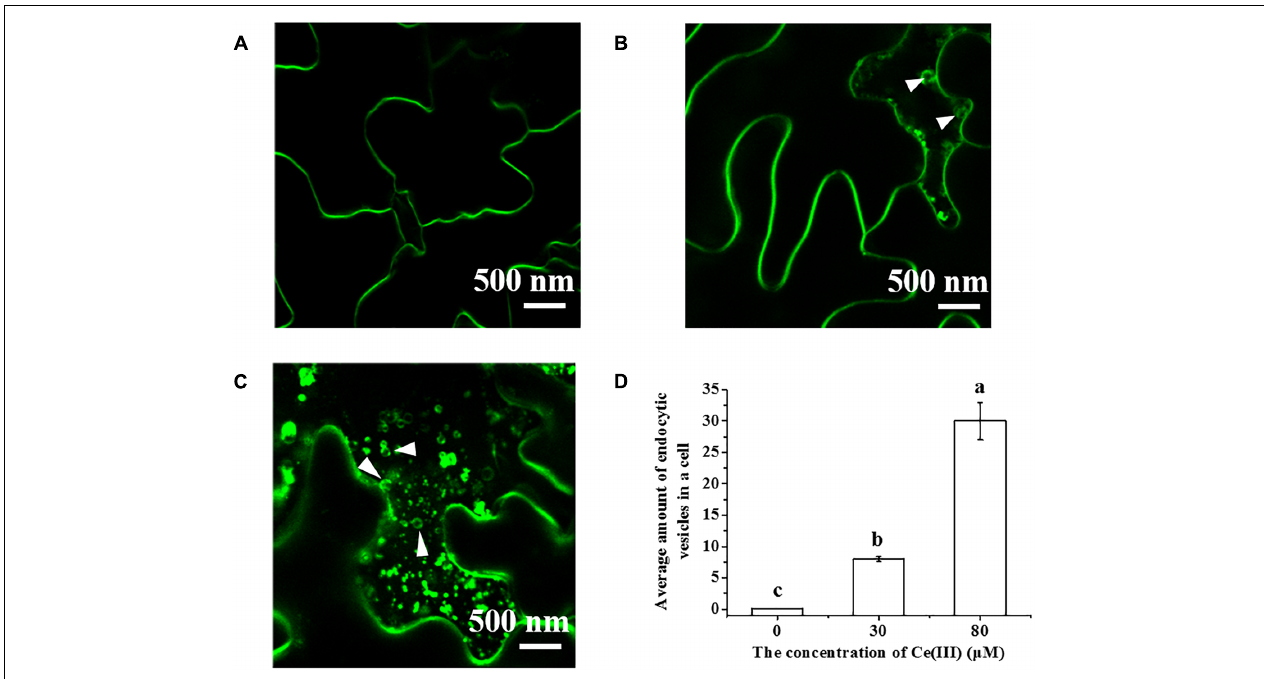
FIGURE 2 | The CLSM images of FM4-64 labeled Arabidopsis hypodermis cells in the presence of Ce(III) at 0 (A) , 30 (B) , 80 µ M (C) and the average amount of pinocytic vesicles in a leaf cell after Ce(III) treatments the different letter on the column means the values of the column are not significantly different at p < 0.05 (D) . The observation was carried out 12 h after the treatments. The pinocytic vesicles were pointed out by white arrows.